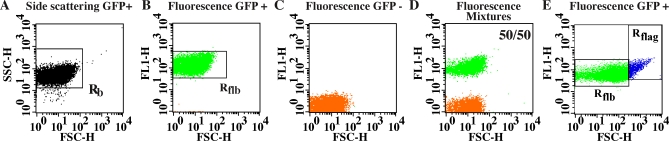
Bacterial FCMScattering (A) and fluorescence dot plots of all GFP-labeled (B), all non GFP-labeled cells (C) and a mixture (50/50) of both (D). Aliquots of exponentially growing cultures were diluted in PBS to obtain a 5 × 106 cells/ml suspension.(E) FL1 dot plots of a slightly aggregated cell population (Rflag, right plot); in this case, 3% of the objects are considered aggregates.